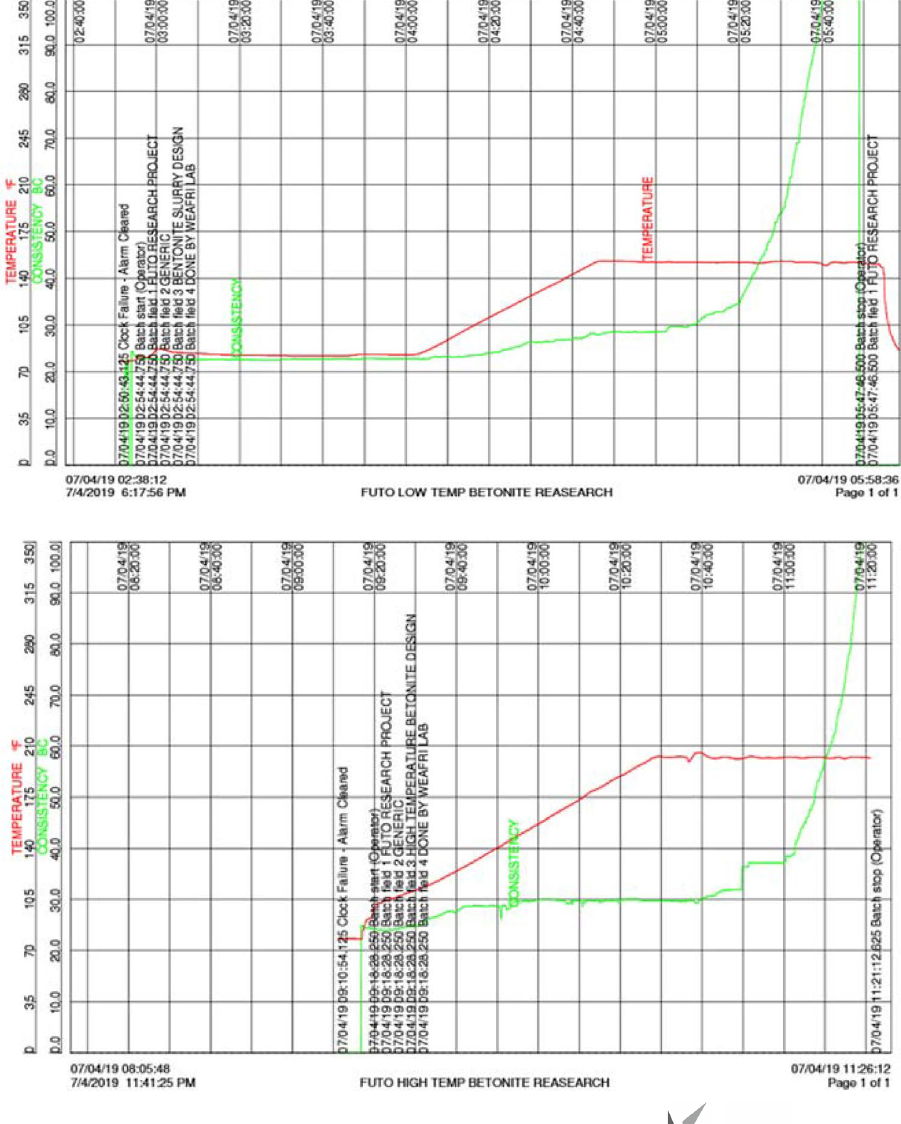
Fig. 7 Cement slurry thickening time for Mucuna solannie and Ben- tonite